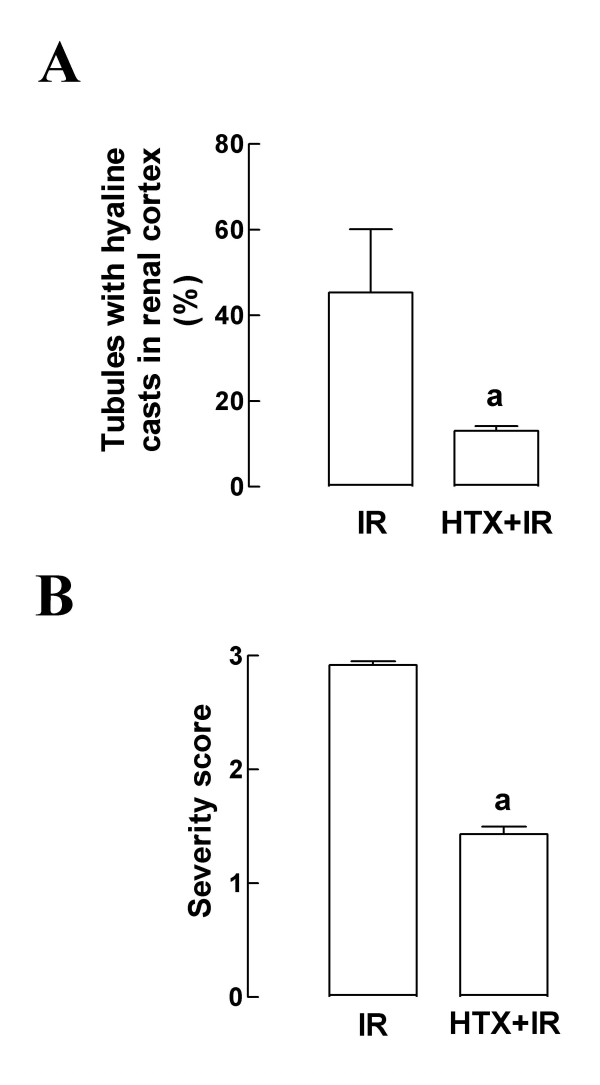
Quantitative analysis of damage in the renal cortex of rats from IR and HTX+IR groups. (A) Percentage of tubules with hyaline casts. n = 4 rats and 60 tubuli/rat. (B). Severity score. Mean ± SD. n = 4 rats and 15 tubuli/rat. aP < 0.001 vs. IR.